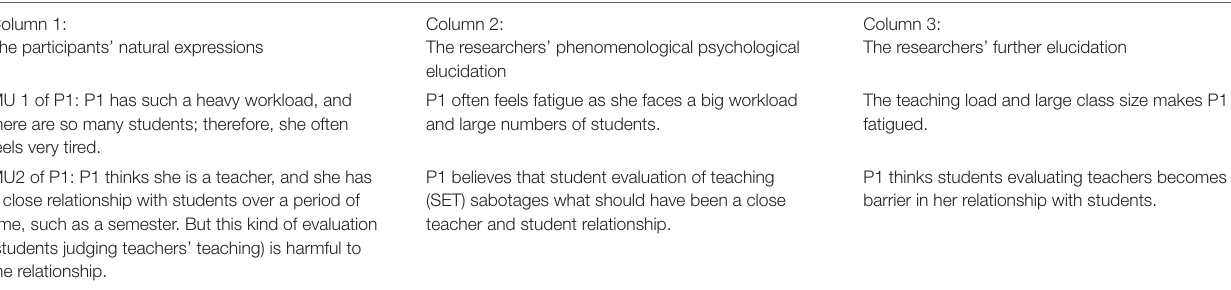
TABLE 1 | An example of psychological reduction in the three-column table, Meaning Units equals MU, and P1 means Participant 1. Column 1: The participants’ natural expressions